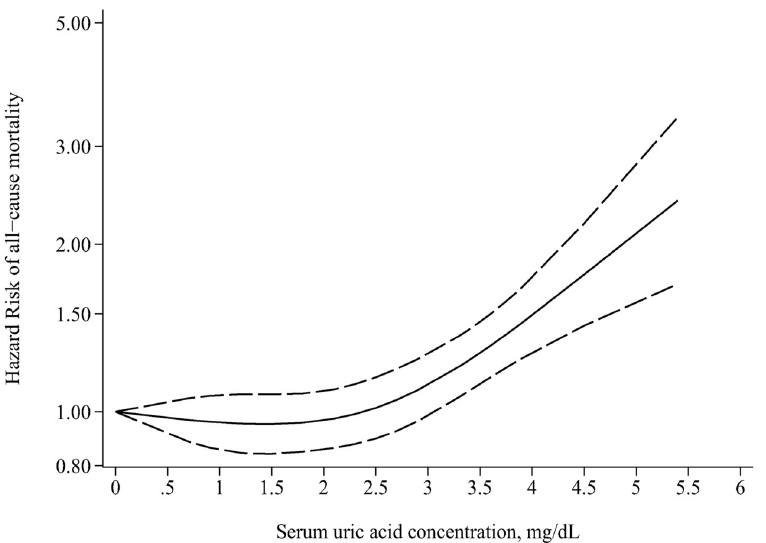
Fig 5. Dose-response relation between SUA concentration and all-cause mortality in PD patients. The solid line and the dash line represent the estimated hazard risk and its 95% confidence interval. SUA, serum uric acid; PD, peritoneal